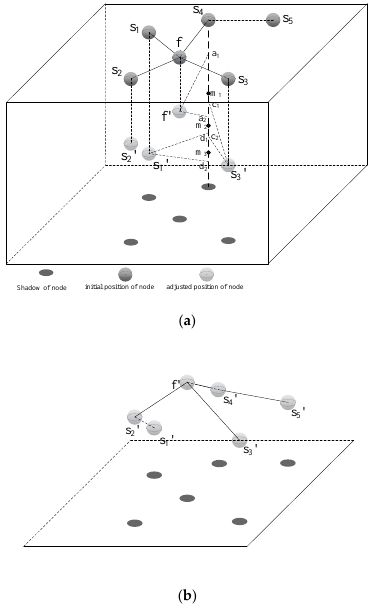
Figure 4. ( a ) Depth calculation process in a cluster (assume that the CRR on m 3 is the minimum and the CRR on m 1 is within rang range of the minimum CRR ; the basic node (next-hop node) of s 2 and s 3 is f , and the basic node of s 1 is s 2 , after their depth is already calculated); ( b ) 3D result of nodes’ depth adjusting. The flow chart of Section 3.2.3 is shown in Figure 5 with a cluster head node f m as an example.